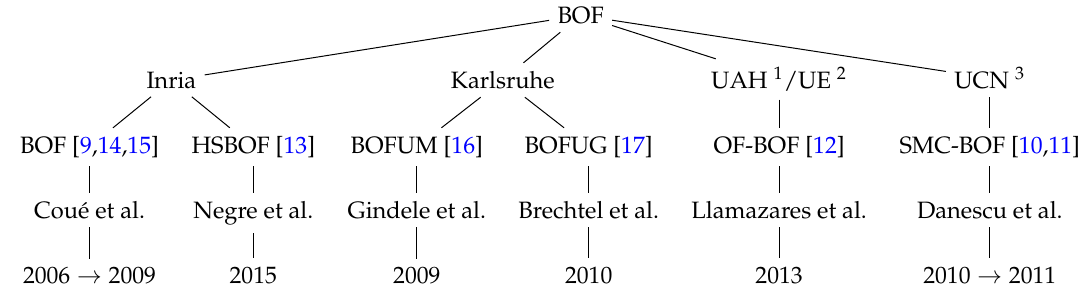
Figure 1. Relationship among Bayesian Occupancy Filter (BOF) techniques, institutions, authors, and publication dates. 1 University of Alcalá de Henares; 2 University of Edinburgh; 3 University of